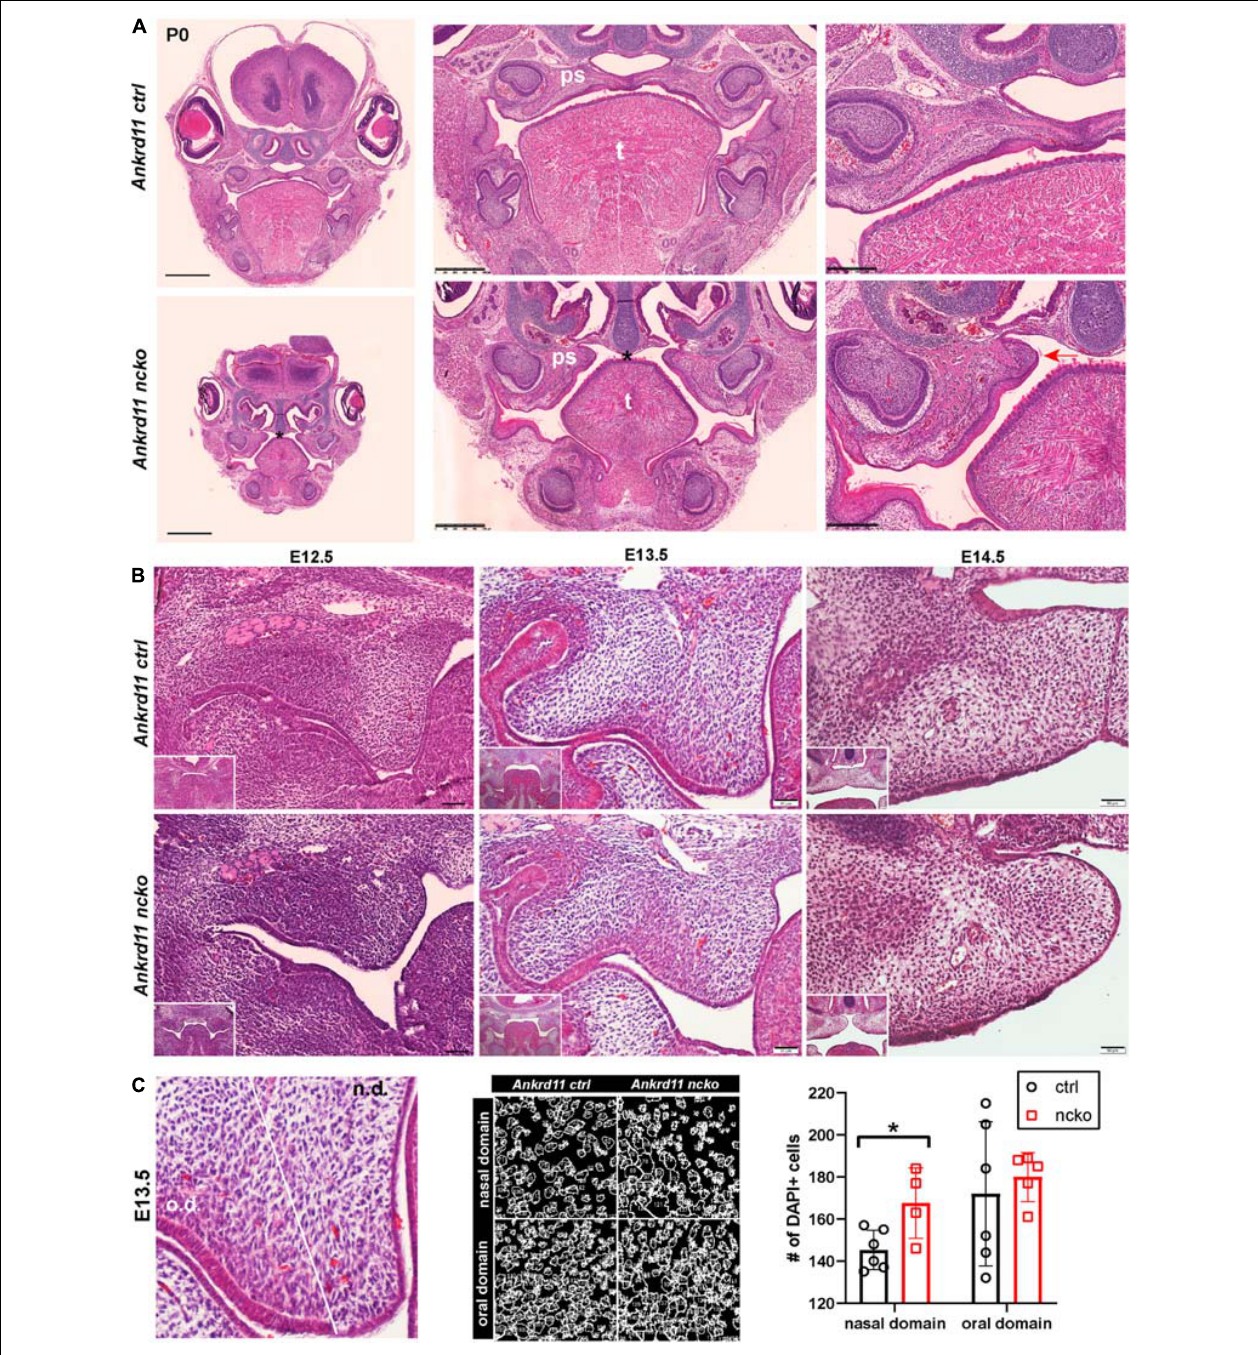
FIGURE 3 | Ankrd11 ncko mice display craniofacial changes early in development. Hematoxylin and eosin (H&E) stain. (A) Representative images of P0 coronal sections of Ankrd11 ctrl (top) and Ankrd11 ncko (bottom) skulls. Note relative size difference between heads. Black asterisk indicates absence of complete palatine boundary separating oral and nasal cavities in Ankrd11 ncko image. Second column images demonstrate overall differences in oral cavity, including smaller tongue and cleft palate. Differences in plane of section in mandible are due to retrognathia in Ankrd11 ncko mice. Right panels focus on palatal shelves, with red arrow indicating unfused advancing medial edge of palatal shelf in mutant mouse. t, tongue; ps, palatal shelf; *cleft palate. Scale bar indicates: 1 mm (first column), 500 µ m (second column), and 250 µ m (third column). (B) Coronal sections of palatal shelves at E12.5, E13.5, and E14.5. Inset in lower right corner of each view is lower magnification image of same mouse, showing overall organization of oral cavity in each mouse. n = 3 from 3 litters. Scale bar represents 50 µ m. (C) Analysis of cell density based on DAPI stain in E13.5 palatal shelves separated into oral and nasal domains. Left: representative H&E stain. Middle: ImageJ-generated density profile showing individual cells. Right: Statistical representation of analysis showing increased cell density in the nasal domain of Ankrd11 ncko palatal shelves (independent two-sample T -test assuming unequal variances, * p < 0.05). n.d., nasal domain; o.d., oral domain.